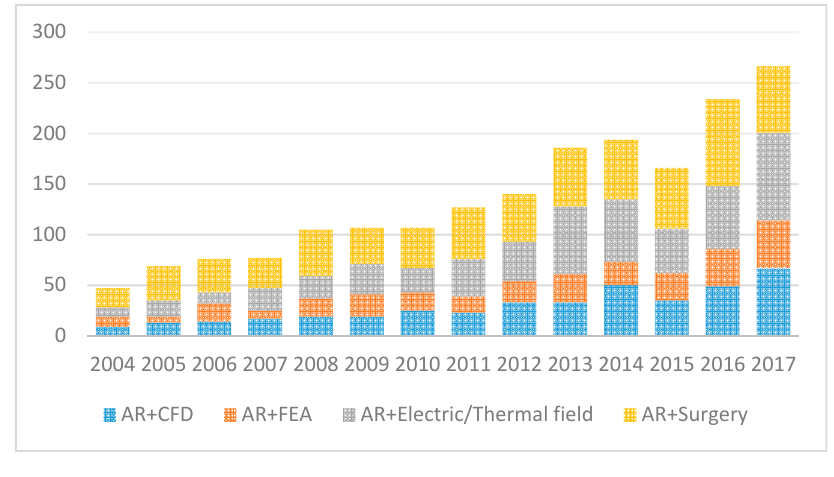
Figure 2 . Trends of AR papers published with different keywords in ScienceDirect. Figure 2. Trends of AR papers published with different keywords in